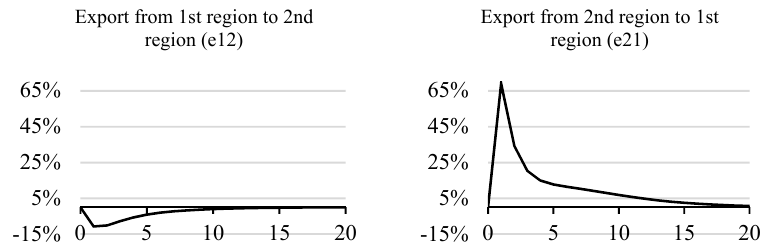
Figure 7. Export from first to second region and export from second to first region. Output in the second region is growing primarily due to the growth of exports to the first region (Figure 8).